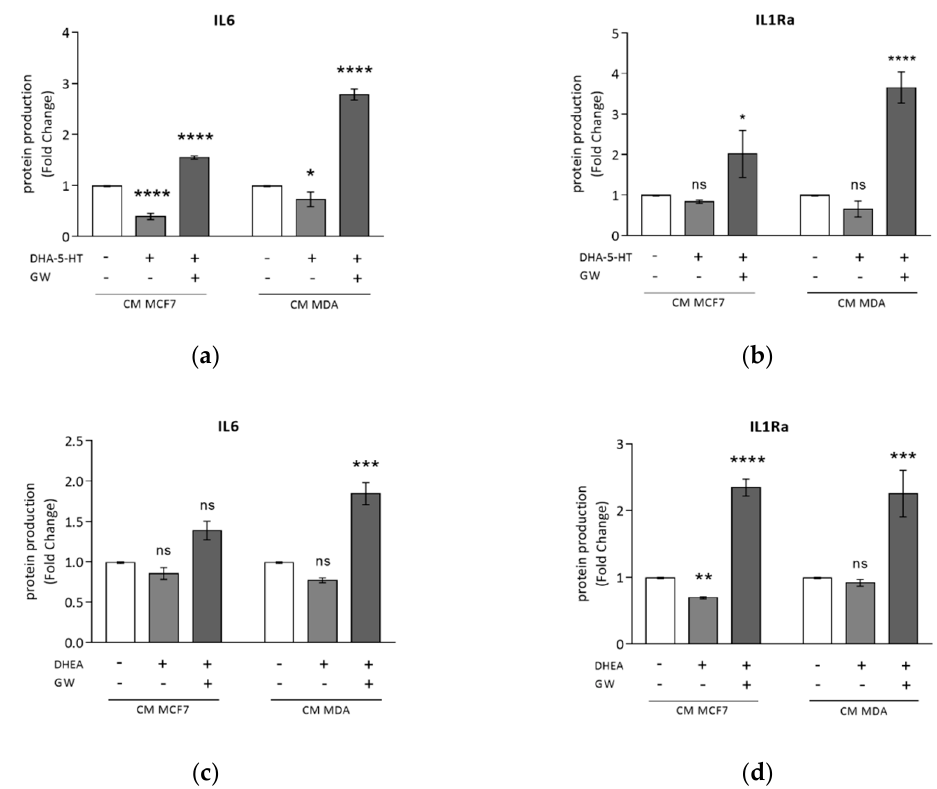
Figure 4. DHA-5-HT and DHEA counteract TAM cytokine secretion induced by MCF7 and MDA-MB-231 breast cancer cell conditioned media. ELISA analyses of IL6 ( a , c ) and IL1Ra ( b , d ) in M0 macrophages incubated with CM MCF7 or CM MDA, and treated with DHA-5-HT 1 μ M (a,b), DHEA 5 μ M ( c and d ) or a combination with GW9662 (GW) (a–d) for 72 h. Data are expressed as means ± SDs. Each experiment was performed three times with duplicate samples. The results are expressed as fold changes with respect to vehicle-treated cells (-).* p < 0.05, ** p < 0.005, *** p < 0.0005, **** p < 0.0001, ns = not significant.